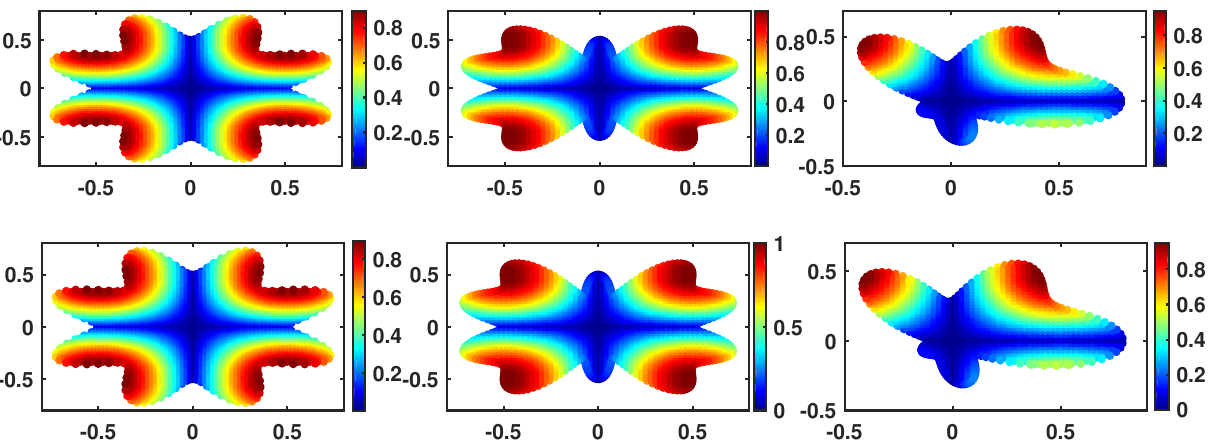
Figure 3. Numerical and analytical solution at T = 1 with τ = 0.1 in Ω 1 , Ω 2 , and Ω 3 for Example 2.